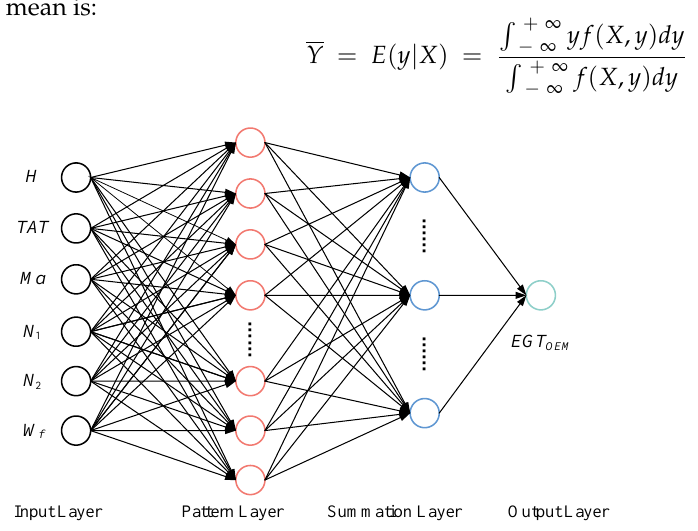
Figure 1. The schematic diagram of the GRNN architecture.